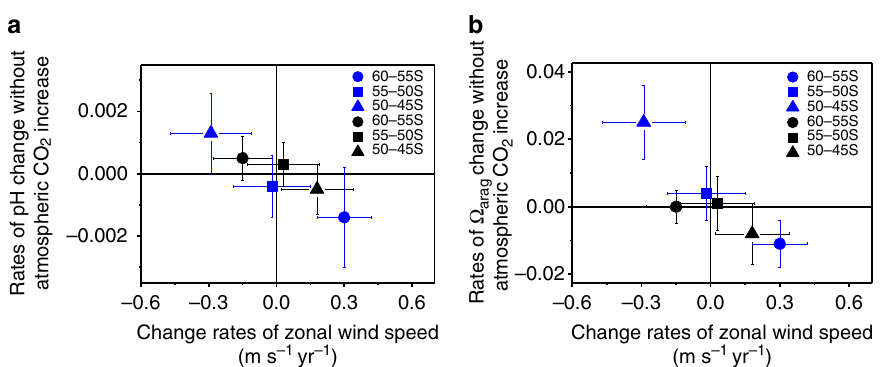
Fig. 4 Impacts of SAM associated winds on acidi fi cation rates. a , b rates of surface pH ( a ) and Ω arag change ( b ) without atmospheric CO 2 increase versus change rates of January zonal wind speed during two periods of 1991 – 2000 (blue) and 2001 – 2011 (black) in the three latitudinal bands of 60° – 55° S, 55° – 50° S and 50° – 45° S. Rates of pH and Ω arag change without atmospheric CO 2 increase are highly negatively correlated with change rates of zonal wind speed with a correlation coef fi cient of 0.92 and 0.89, respectively. Rates of pH and Ω arag change without atmospheric CO 2 increase were the observed rates of pH @in situ and Ω arag@in situ change, subtracting their rates predicted from atmospheric CO 2 increase alone (see 'Methods'). In this fi gure, negative change rates of pH or Ω arag denote enhanced acidi fi cation compared to that predicted from atmospheric CO 2 increase alone. The bars show one standard deviation of change rates as shown in Fig. 3